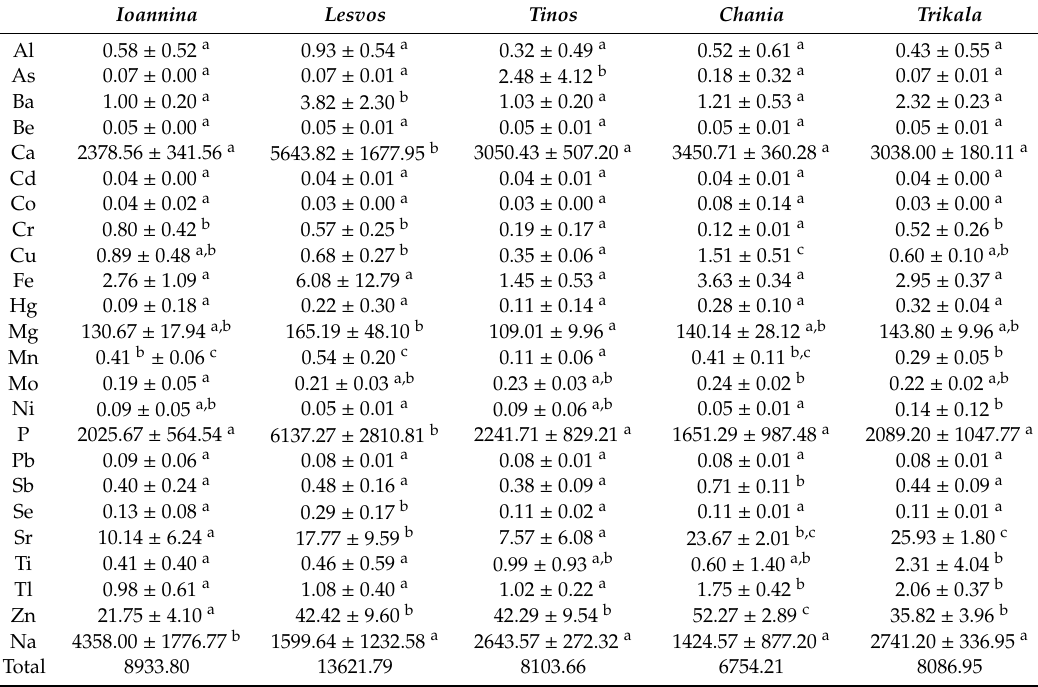
Table 2. Mean values (mg / kg) and SDs of minerals for the graviera cheese samples tested. Ioannina Lesvos